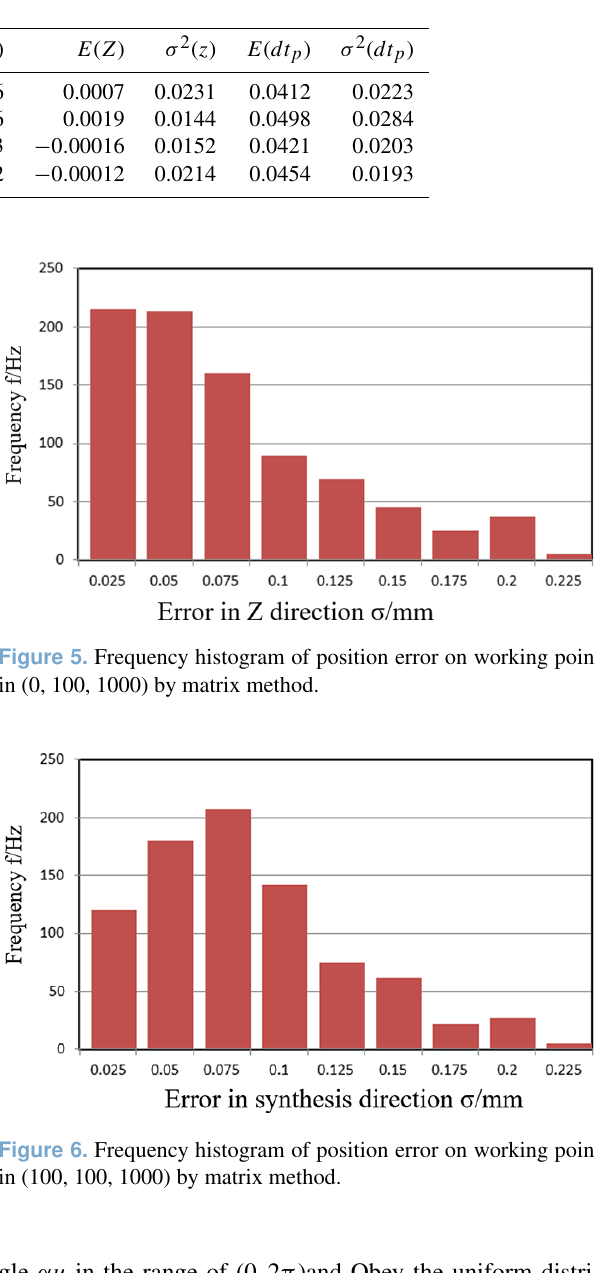
Table 1. The statistical parameters of position errors influenced by joint clearance in different positions using matrix method.